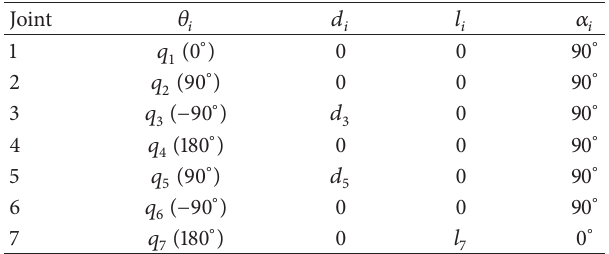
Table 1: D-H parameters of the human